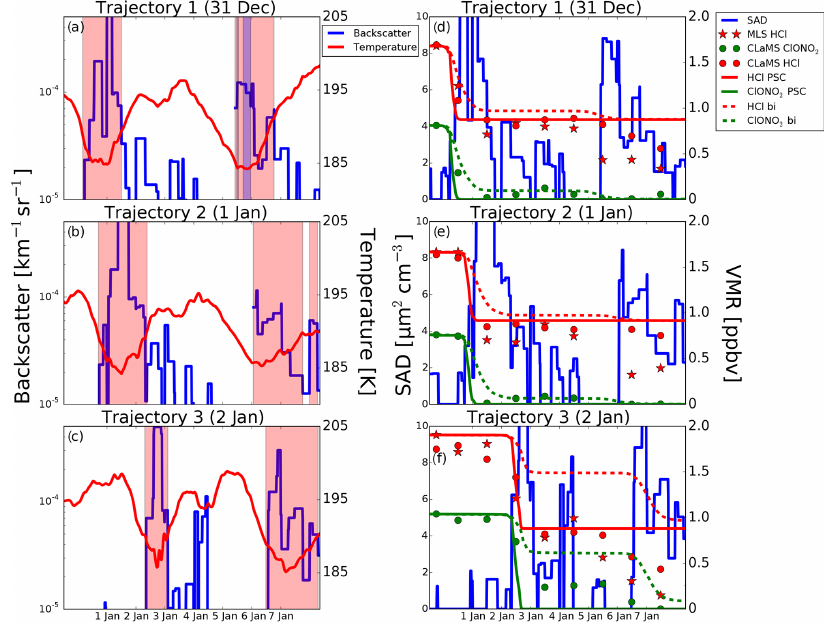
Figure 6. Temporal evolution of three trajectories on 510K potential temperature which were initialized at the same time at different locations. The trajectories encounter their first maximum in backscatter on 31 December (a, d) , 1 January (b, e) and 2 January (c, f) , respectively. The period from 30 December 2009 to 8 January 2010 is shown for all three trajectories. Left column (a–c) shows backscatter (blue), temperature (red), time below T NAT -3K (red shading) and time below T ICE (blue shading). Right column (d–f) shows surface area density (blue), HCl (red) and ClONO 2 (green). Red stars are the daily mean HCl mixing ratios observed by MLS interpolated on the position of the trajectory and circles are CLaMS mixing ratios of HCl (red) and ClONO 2 (green), respectively. Solid red and green lines represent HCl and ClONO 2 where SAD for calculating heterogeneous reaction rates is calculated from the observed backscatter. Dashed red and green lines represent HCl and ClONO 2 where SAD is calculated for a binary